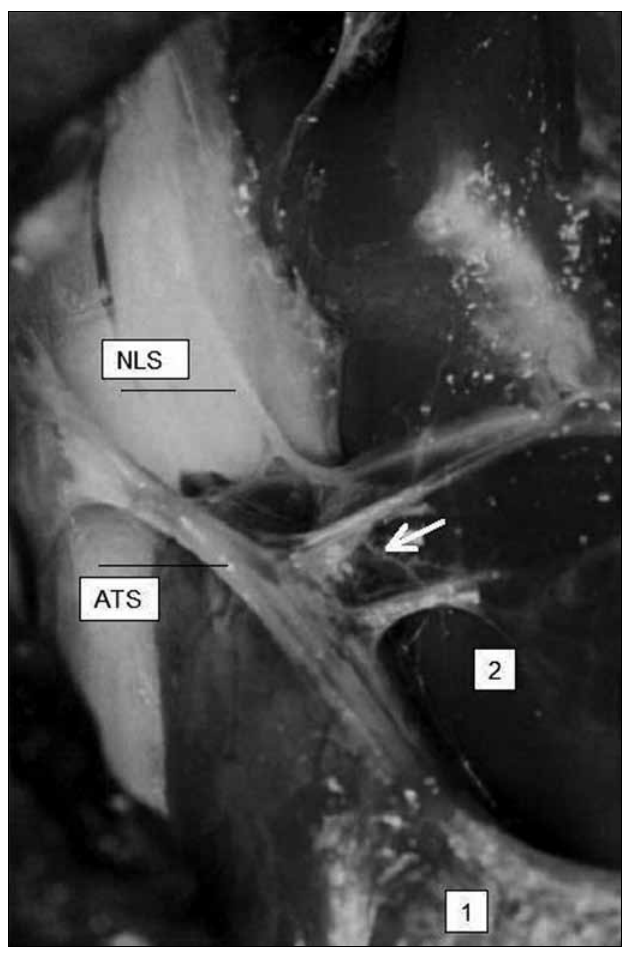
Figure 5. Right-lateral view of the neck at the larynx, showing the parallel and posterior trajectory of the external laryngeal nerve (white arrow) relative to the superior thyroid artery. Key: (1) tip of the right superior pole of the thyroid gland; (2) right cricothyroid muscle; SLN, superior laryngeal nerve.